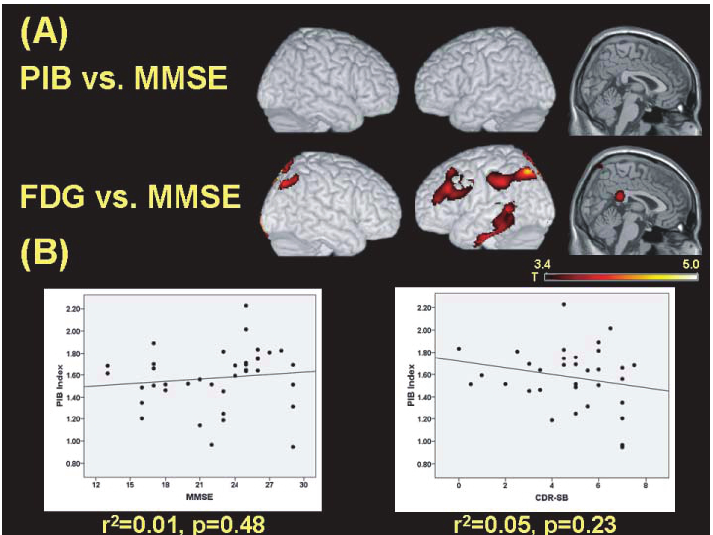
Fig. 3. Relationships between PIB, FDG and AD severity. (A) Voxel-wise parametric regressions between PIB and MMSE (top row) and FDG and MMSE (bottom row) in 38 AD patients (age 68.4 ± 10.6, MMSE 22.8 ± 4.5), controlling for age, sex and education. Images are thresholded at p < 0.001, uncorrected for multiple comparisons. MMSE correlated positively with FDG in bilateral parietal and left frontal, lateral temporal and posterior cingulate cortex, while no significant correlations (positive or negative) were found between PIB and MMSE at this threshold. (B) Regression of PIB Index (mean distribution volume ratio (DVR) in frontal, parietal, lateral temporal and cingulate cortex) versus MMSE (left panel) and Clinical Dementia Rating Sum of Boxes (CDR-SB, group mean 4.7 ± 2.1, right panel) reveal no significant correlations between amyloid burden and measures of AD